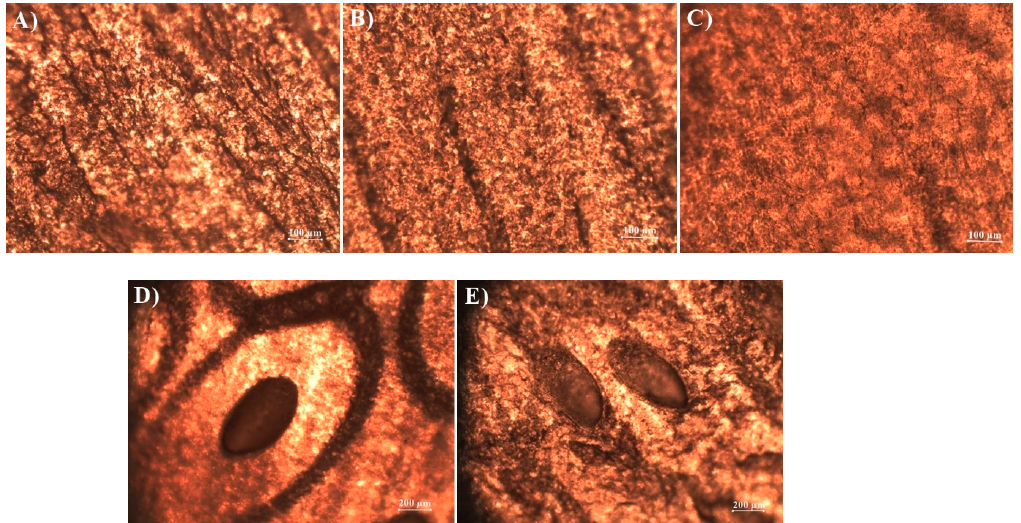
Figure 3. Surface changes in nail clippings throughout the penetration experiment: ( a ) natural structure nail surface; ( b ) nail after 24 h in 5% urea solution; ( c ) nail after 24 h in 5% thioglycolic acid solution; ( d ) laser-affected nail surface; ( e ) laser-affected nail surface after 24 h application of nail lacquer with 5% thioglycolic acid as chemical